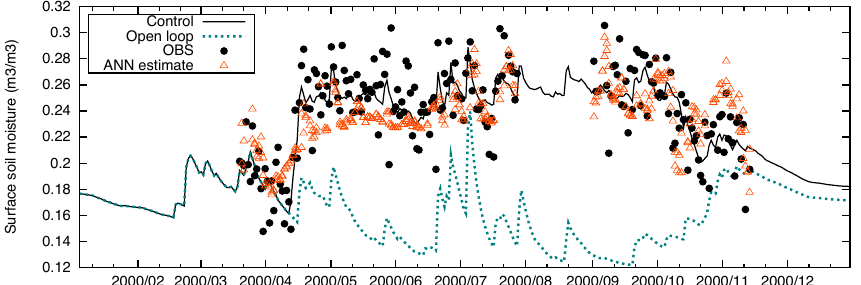
Figure 9. Time series of the Control simulation (black line), open loop (dashed line), simulated observations (filled circles) and estimates from the trained ANN (triangles) for the year 2000.